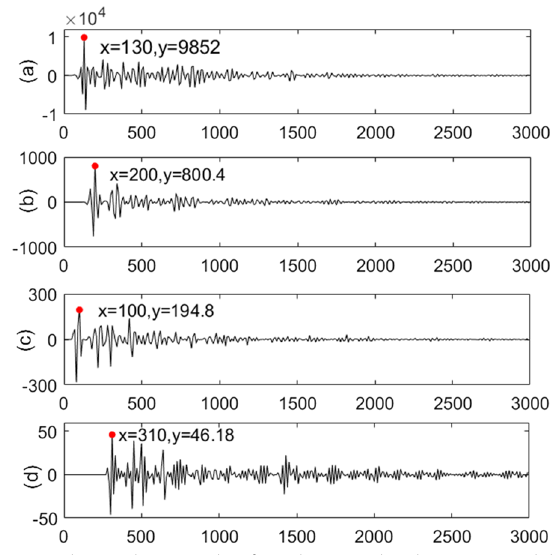
Fig. 7 The simulation results of traveling wave heads arriving at valid